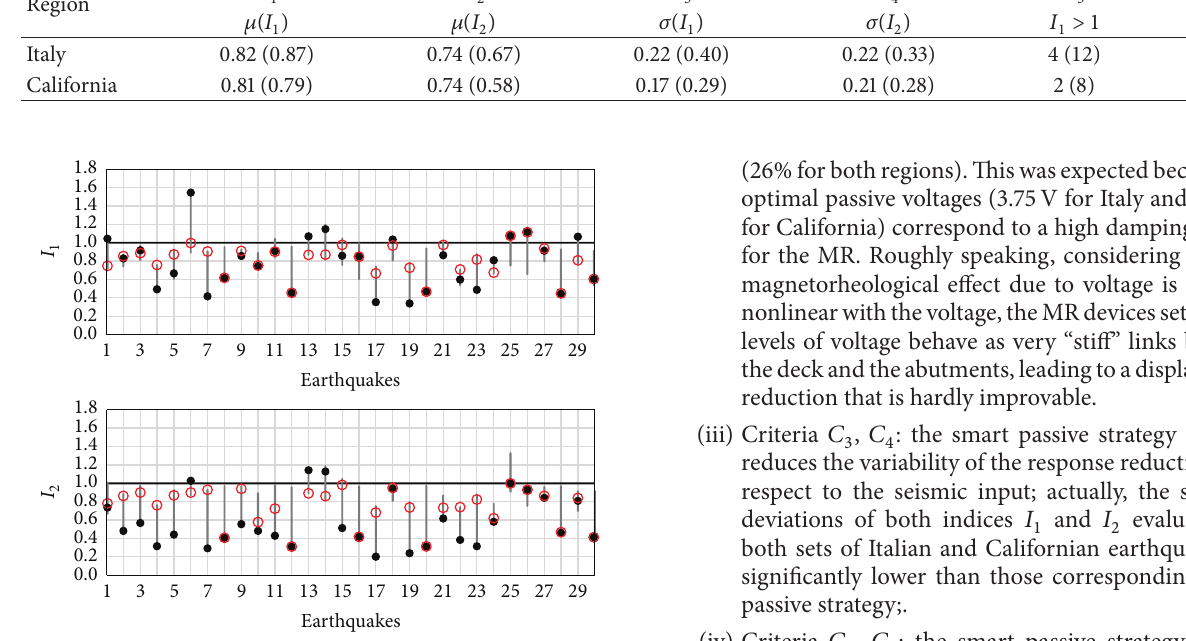
Figure 9: California: performance indices for the smart passive strategy (red circles) compared to the pure passive ones (black